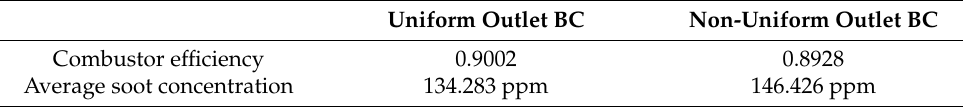
Table 1. Comparison between uniform outlet BC and non-uniform outlet